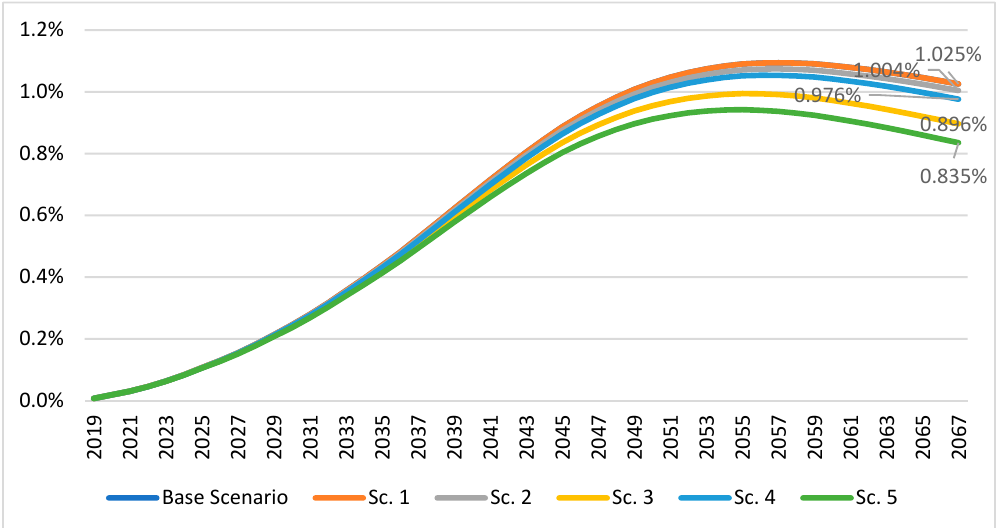
Figure 9. Annual savings/GDP with the application of the SF. Various scenarios. Source: Own elaboration.